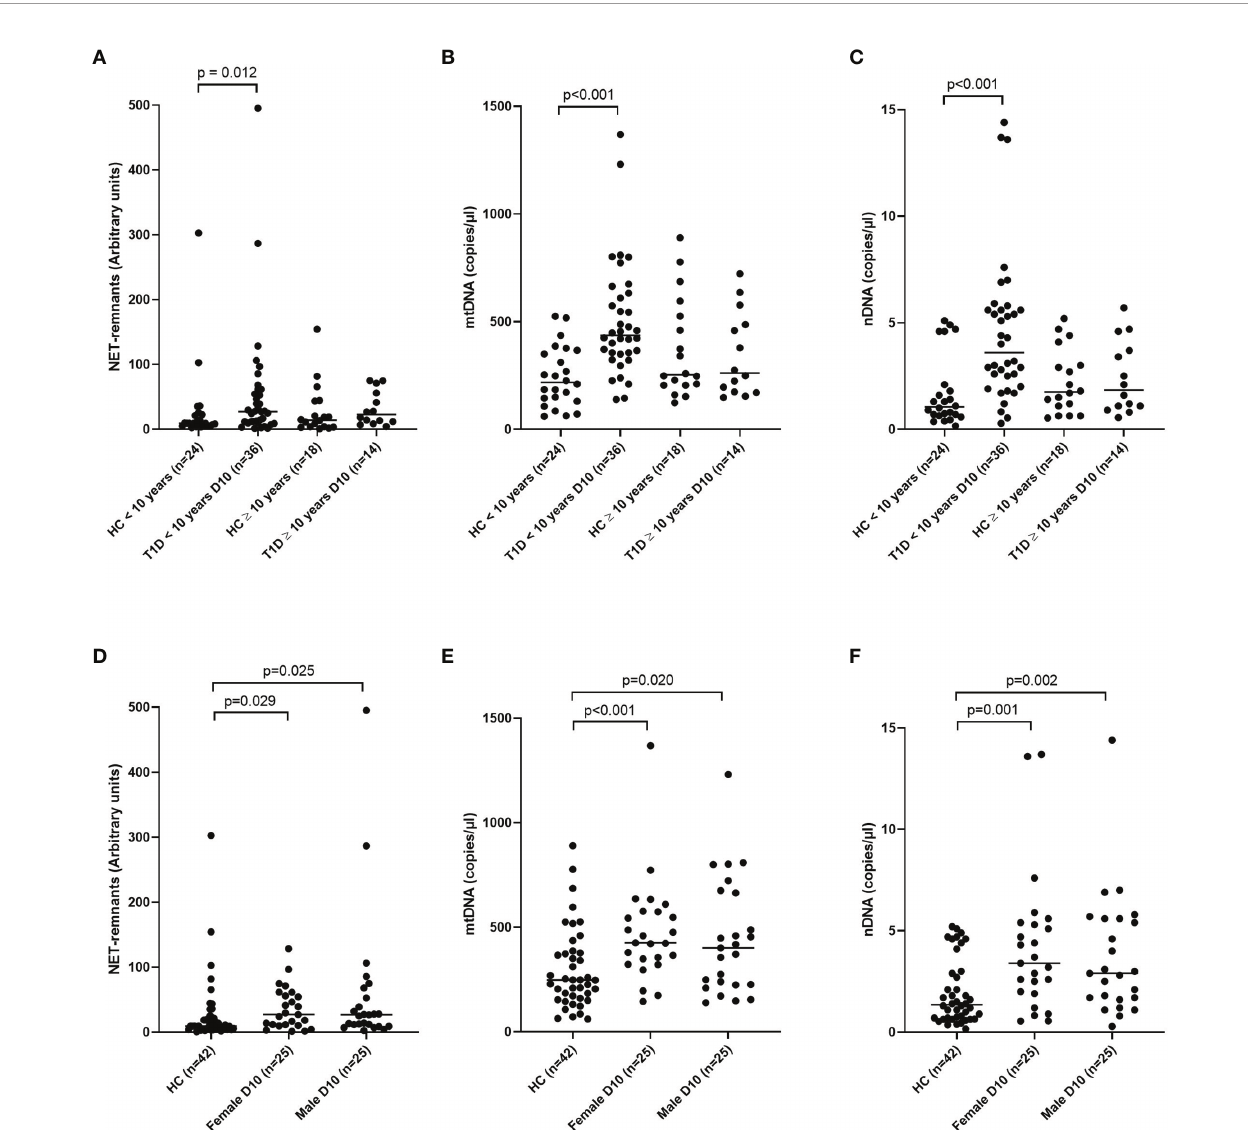
FIGURE 7 | T1D and healthy children in cohort 1 subgrouped into younger than 10 years and 10 years or older for NETs (A) , mtDNA (B) and nDNA (C) and subgrouped into male and female for NETs (D) , mtDNA (E) and nDNA (F) (Mann-Whitney test). Gender in the healthy control group was not available. HC, healthy